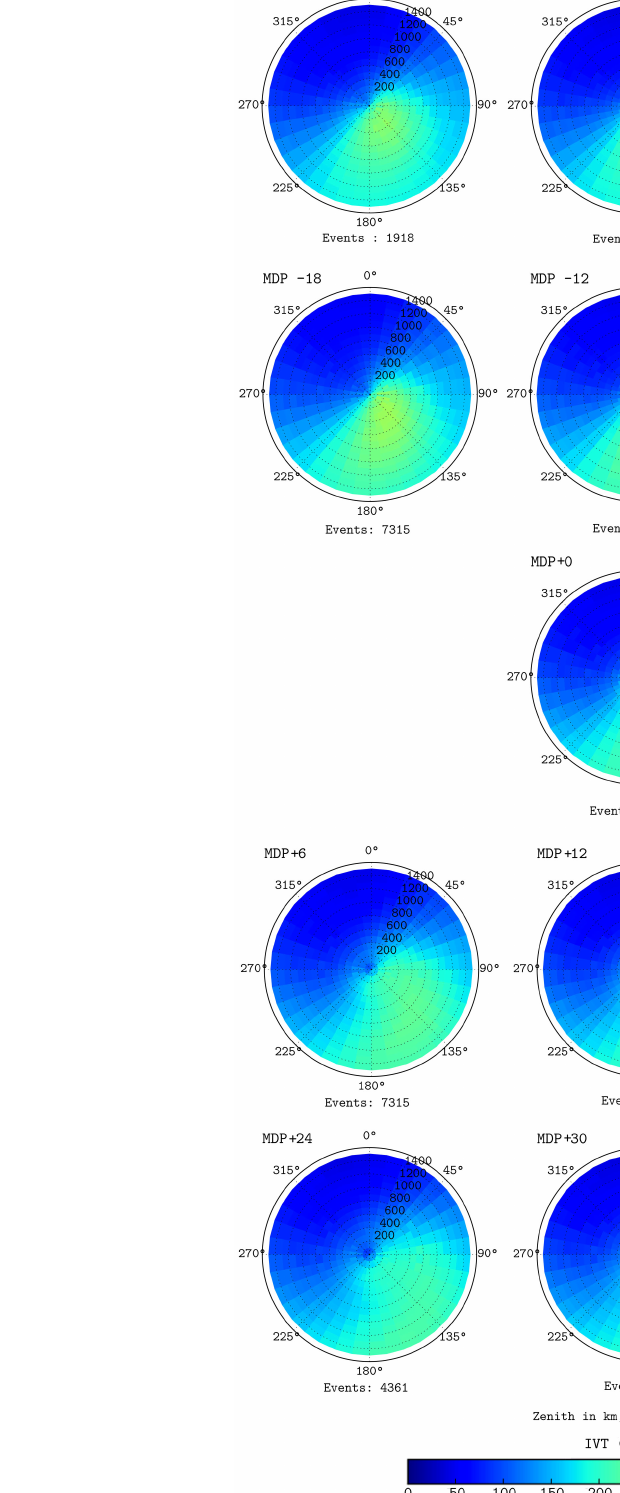
Earth Syst. Dynam., 9, 91–102, 2018